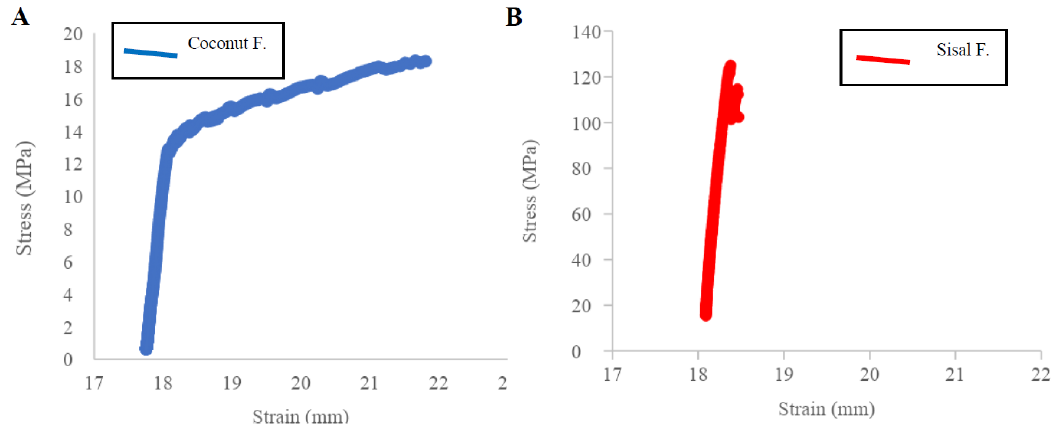
Figure 4. The relationship between stress vs. strain (load and elongation) average for ( A ) coconut fibers and ( B ) sisal fibers. In observing the two graphs, Sisal has greater ductility that coconut fibers; which is an advantage when suturing.